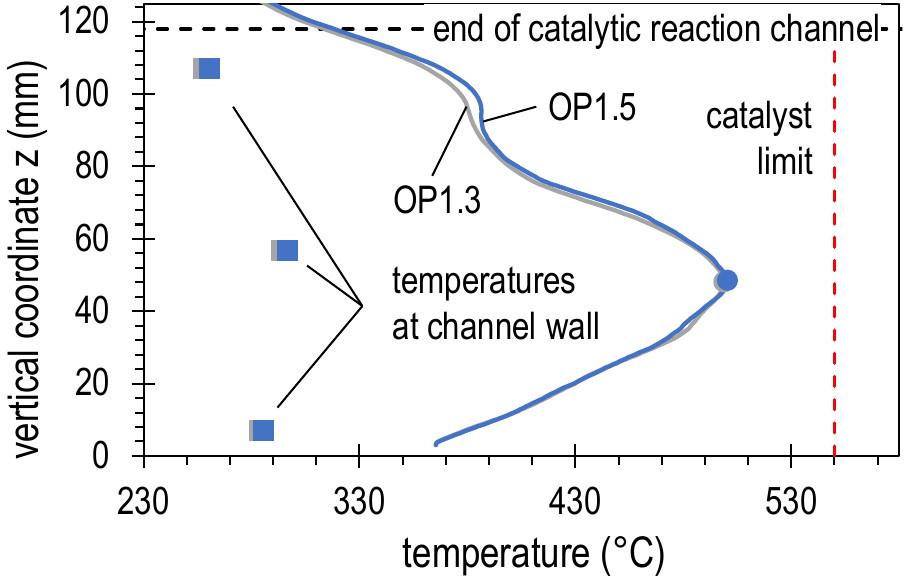
Figure 16. SC1. Axial temperature profiles (average) of the structured reactor of FAU_CH4_TR. A summary of the evaluation of the hydrogen conversion, X H2 , and methane yield, Y CH4,COx , is reported in Figure 17 for the five operating points of SC1. At the three com- parable operating points, OP1.1, OP1.3, and OP1.5, full methane yield was achieved after the two-stage process with intermediate water separation. The hydrogen conversion was around 94.5% (over-stoichiometric feed gas composition). For OP1.2 and OP1.4, similar values for the final product gas are to be expected, but no product gas measurement was made after the second reactor stage at these points. The X H2 and Y CH4,COx of OP1.2 and OP1.4 (CO-rich gases and lower syngas power) after the first stage were higher ( ≈ 6.5%) than the values at the operating points with equal amounts of CO and CO 2 and higher volume flow rates. A methane yield of around 91% was achieved in just one reactor